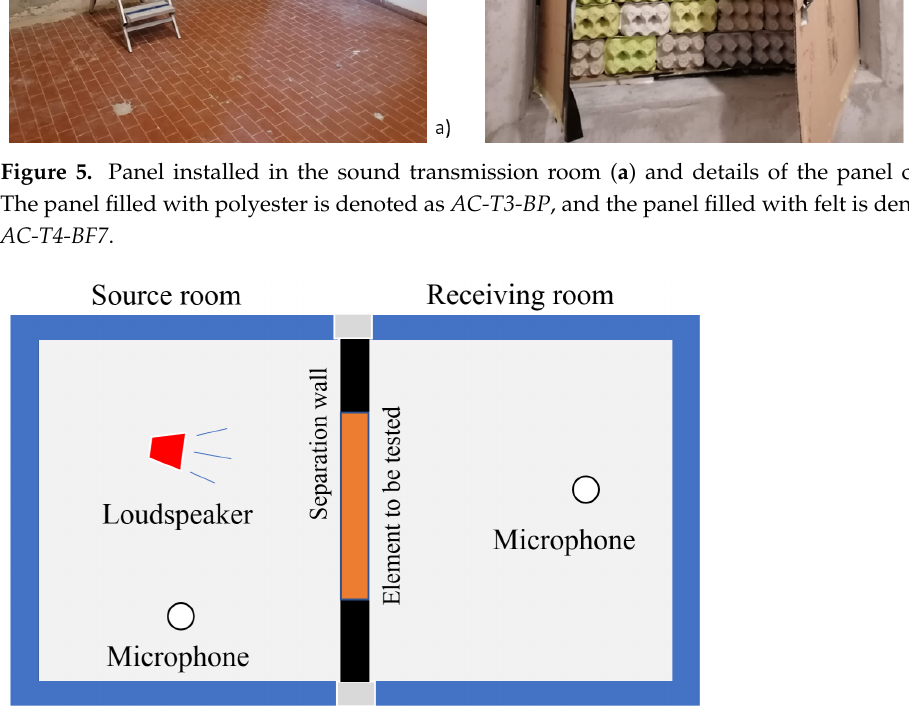
Figure 6. Plan of the sound transmission room. The source room is 50 m 3 in volume and 79.5 m 2 in total surface area, while the receiving room is 60 m 3 and 91.5 m 2 . The opening in the separation wall in which the panel has been installed is 1 × 1.2 m in